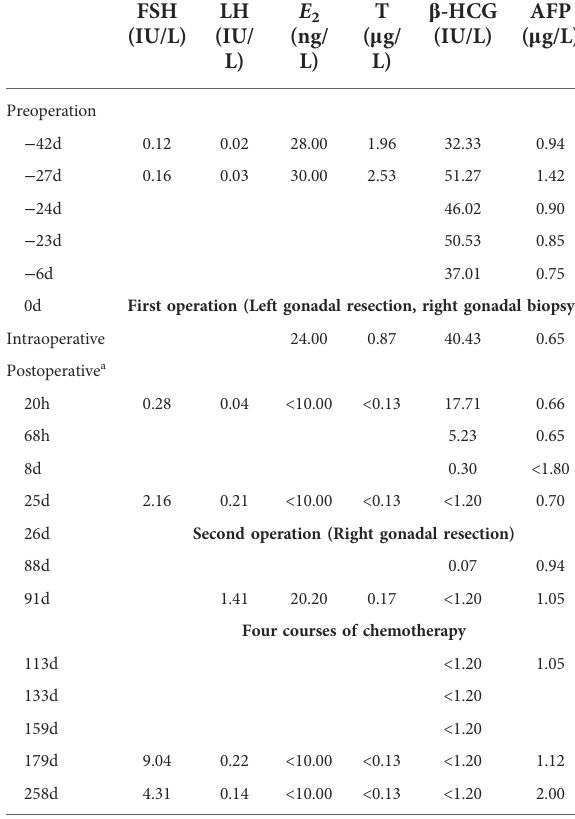
TABLE 3 Changes of hormone levels after